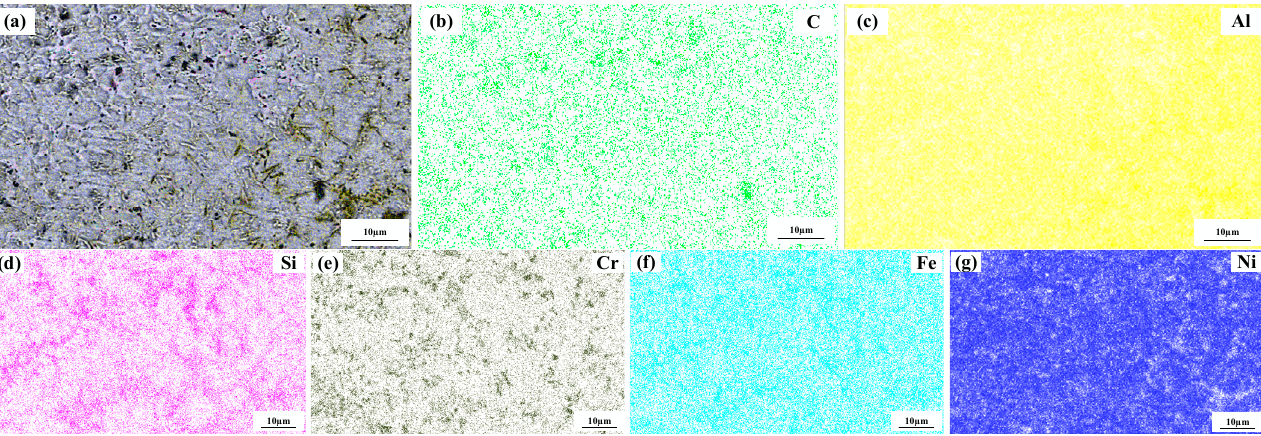
Figure 5. Composition analyses of surface scanning for specimen 2 (0.5% graphene content): ( a ) SEM image; ( b ) C; ( c ) Al; ( d ) Si; ( e ) Cr; ( f ) Fe; ( g ) Ni.